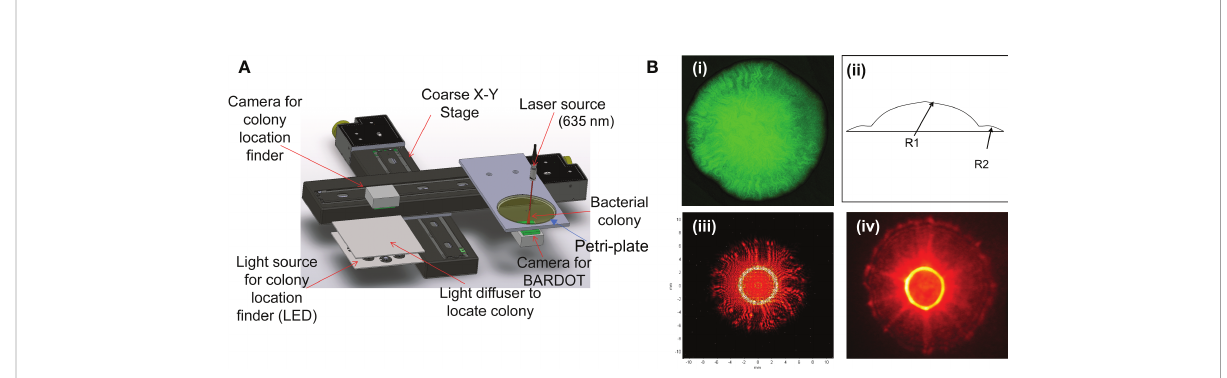
FIGURE 1 (A) Schematics of BARDOT (Bacterial Rapid Detection using Optical scattering Technology). Source (Singh et al., 2014); (B) Modeling of BARDOT-generated scatter signature of green- fl uorescence protein (GFP) expressing Listeria monocytogenes (Lm) colony. (i) Confocal image of the colony (~1 mm diameter) of GFP-expressing Lm, (ii, iii) Scatter image modeling using two-stage curvature R1 and R2, and (iv) actual scatter image of the colony. Source (Banada et al.,